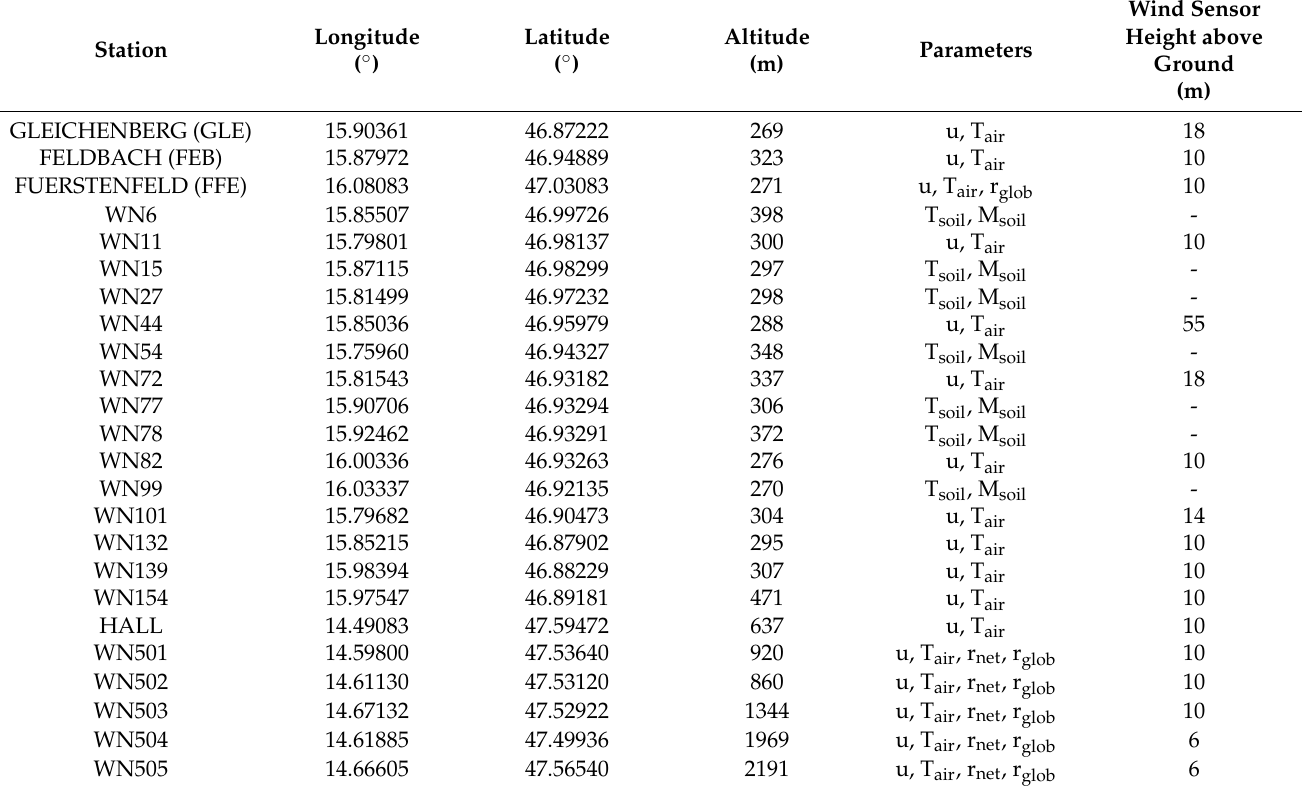
Figure 3. Location of the monitoring sites in ( a ) the Johnsbach (100 m isopleths) and ( b ) Feldbach (25 m isopleths) modelling domains. Table 2. Monitoring sites used for model evaluation and observed parameters (u = wind, T air = air temperature, T soil = soil temperature, M soil = soil moisture, r net = net radiation, r glob = global radiation). “WNxxx” stations belong to the WegenerNet, the other stations are operated by the central weather service